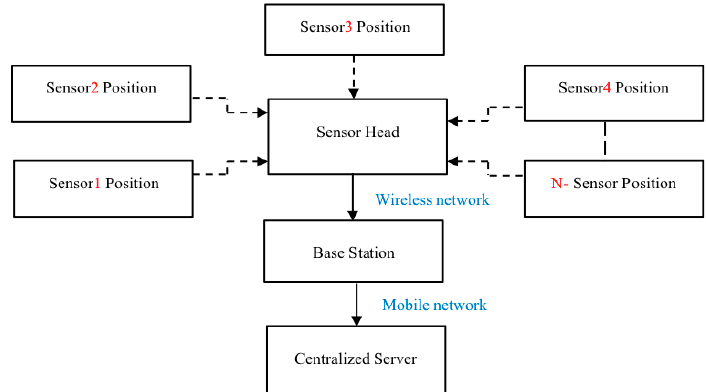
Fig. 3. Sensors Network Block